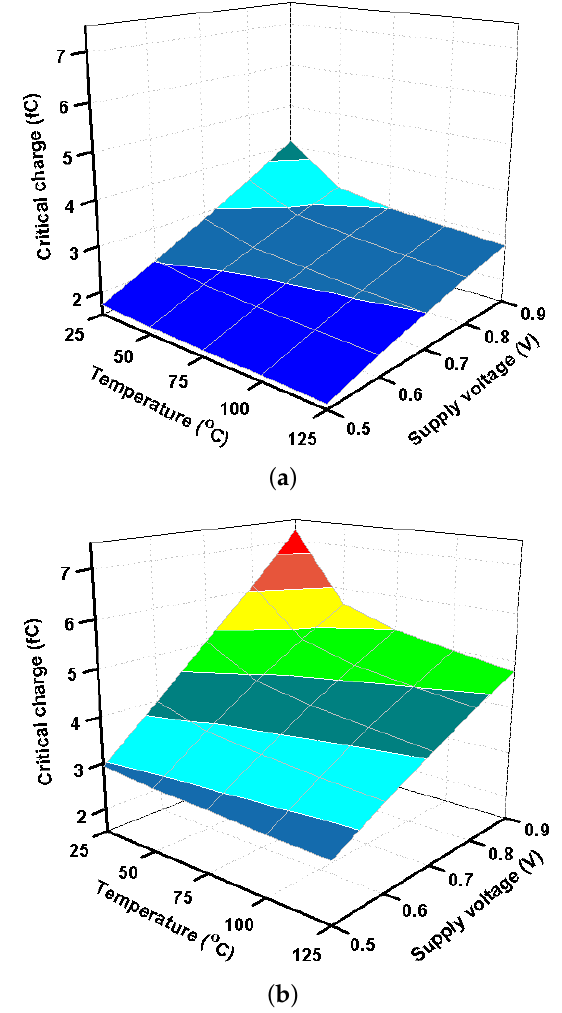
Figure 7. Critical charge variation at different supply voltages and temperatures for the ( a ) 6T SRAM cell and the ( b ) AS10T SRAM